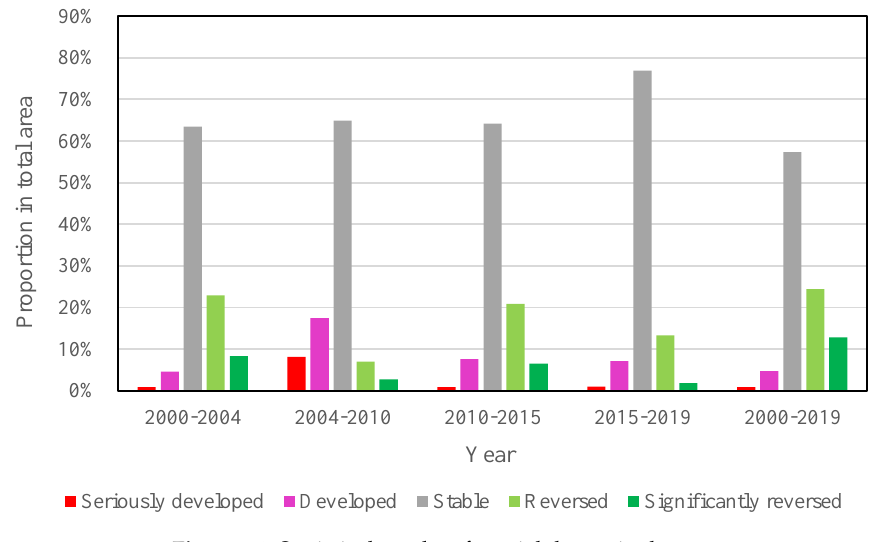
Figure 14. Statistical results of spatial dynamic change.